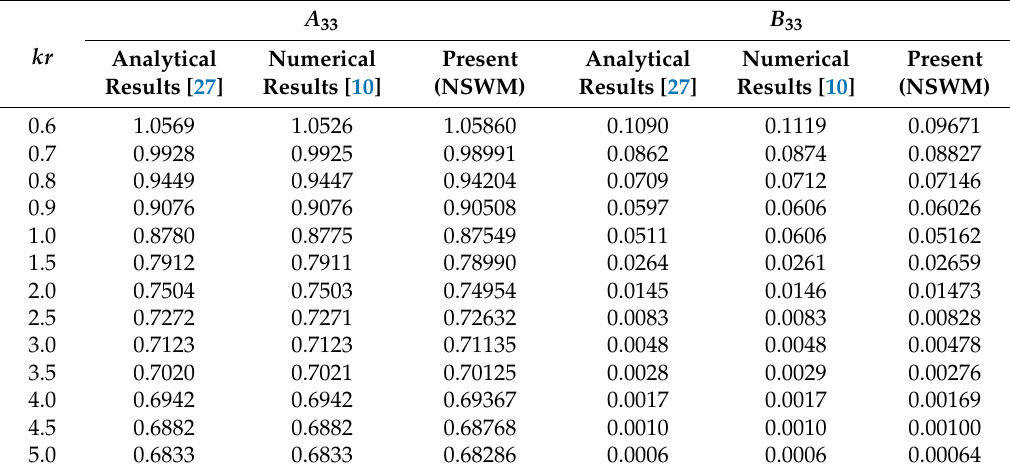
Table 5. Added masses and damping coe ffi cients of the sphere in heave motion ( Fr = 0.4, h = 2.0 r , k ec r = 0.3906).